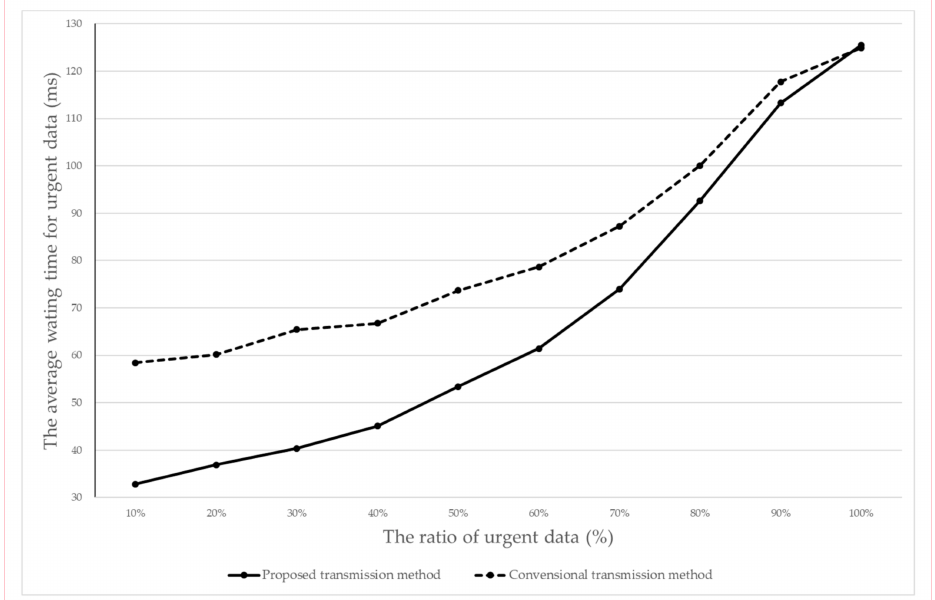
Figure 10. The average waiting time of the urgent